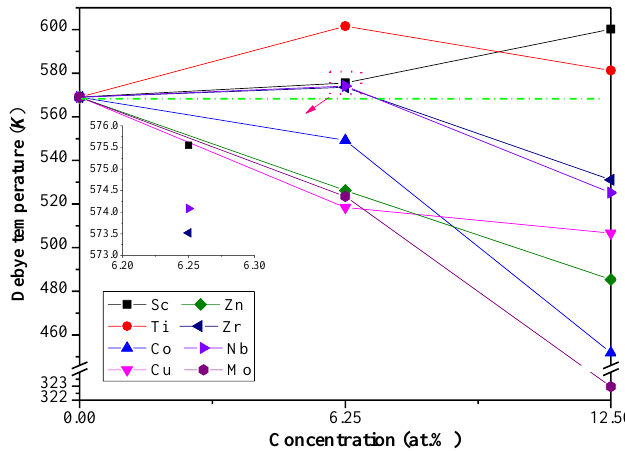
Figure 4. The calculated Θ D for Al 3 Li doped with alloying element X (X= Sc, Ti, Co, Cu, Zn, Zr, Nb, and Mo) with different doping concentration.